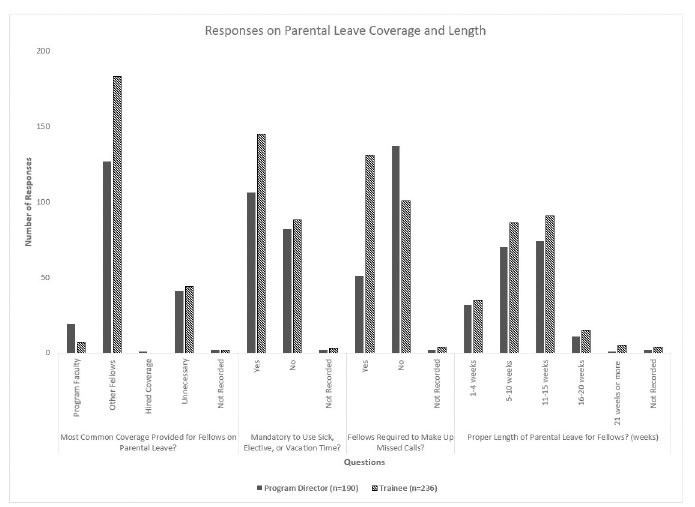
Fig 2. Responses on parental leave coverage and